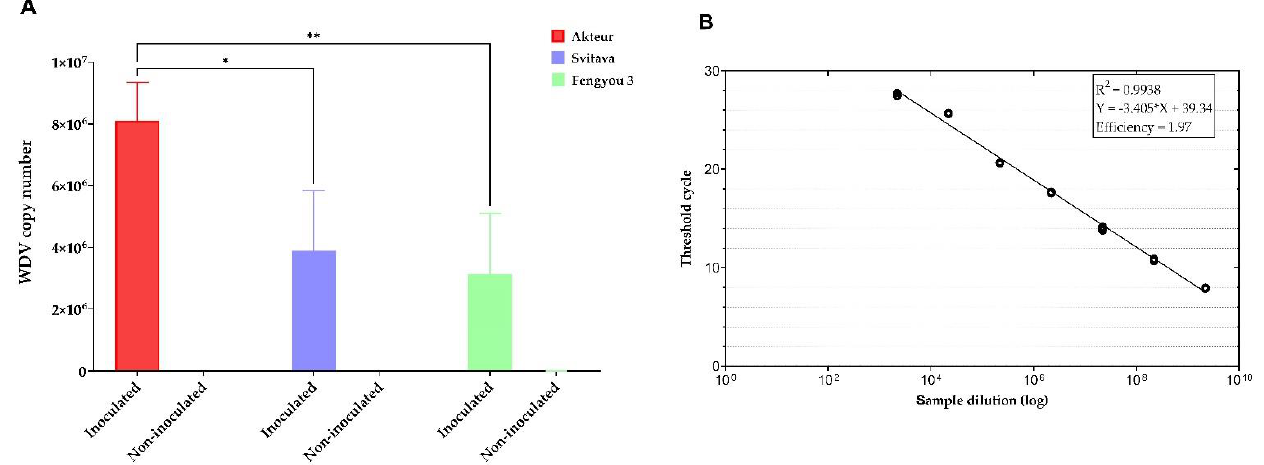
Figure 2. ( A ) The virus copy number detected in each individual wheat genotype by qPCR, two-way ANOVA and Tukey’s multiple comparison test was applied to detect the statistical significance of the WDV titre in inoculated Fengyou 3 and Svitava compared to Akteur (a susceptible genotype) where * = p < 0.05 and ** = p < 0.01. ( B ) The calibration curve for SYBR Green I-based qPCR amplification of standard WDV DNA, with the specific set of primers UnivWDVfw and UnivWDVrv [35] calculated based on the WDV copy number in each sample.